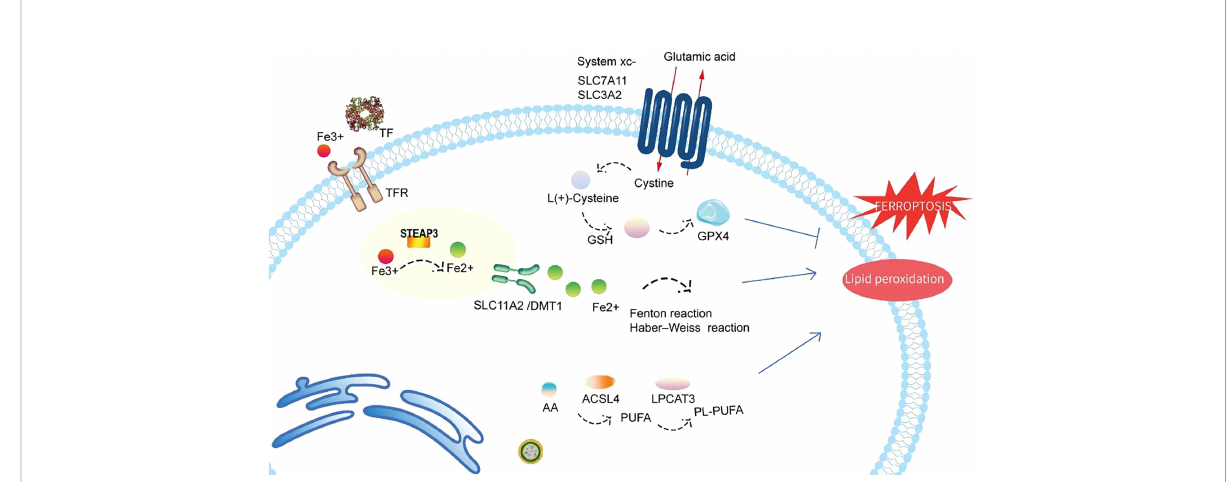
FIGURE 2 Schematic representation of the mechanism of ferroptosis. Ferroptosis is a novel form of cell death precisely regulated by iron metabolism, antioxidant processes, and lipid metabolism. Fe3+ imported through the transferrin receptor is converted to Fe2+ in endosomes and released from endosomes by DMT1 (also known as SLC11A2). Excess Fe2+ can induce ferroptosis through reactive oxygen species generated by the Fenton reaction and Haber – Weiss reaction. GPX4 is the major endogenous mechanism that suppresses lipid peroxidation. Cystine enters cells through system Xc-, and cystine is subsequently converted to cysteine, which generates glutathione (GSH), a cofactor for GPX4. Both LPCAT3 and ACSL4 also exert direct or indirect actions on lipid peroxidation of membrane PUFAs. TF, transferrin; TFR, transferrin receptor; STEAP3, six- transmembrane epithelial antigen of prostate 3; SLC11A2/DMT1, divalent metal transporter 1; SLC7A11, solute carrier family 7 member 11; SLC3A2, solute carrier family 3 member 2; system xc-, cystine/glutamate antiporter system; GPX4, glutathione peroxidase 4; GSH, glutathione; PL-PUFA, phospholipid-bound polyunsaturated fatty acids; PUFA, polyunsaturated fatty acid; ACSL4, acyl-coenzyme A synthetase long-chain family member 4; LPCAT3, lysophosphatidylcholine acyltransferase